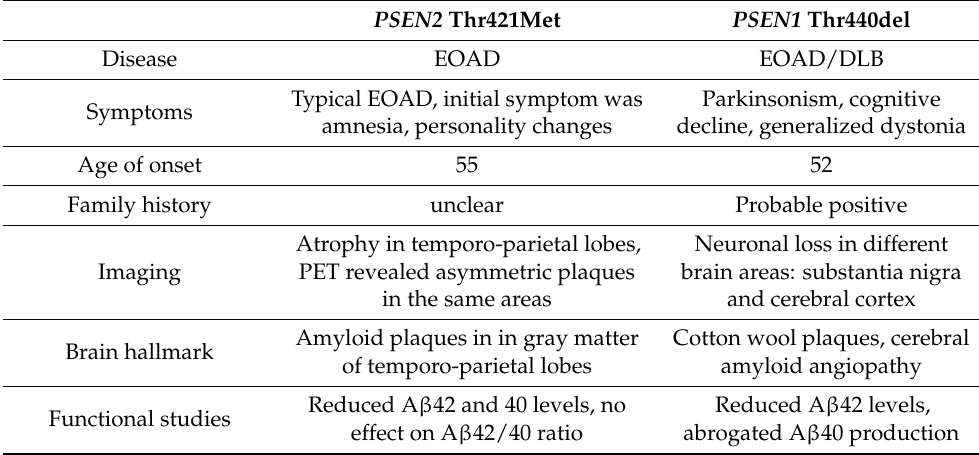
Table 2. Comparison of PSEN1 Thr440del and PSEN2